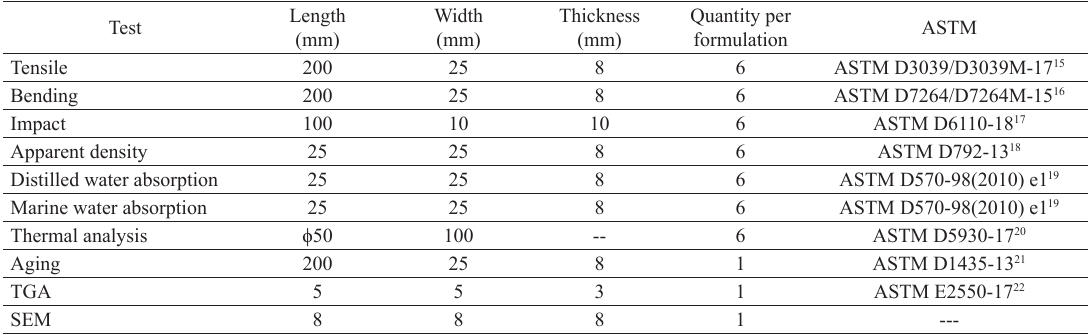
Table 2. Dimensions, quantities and standards used in the specimens.